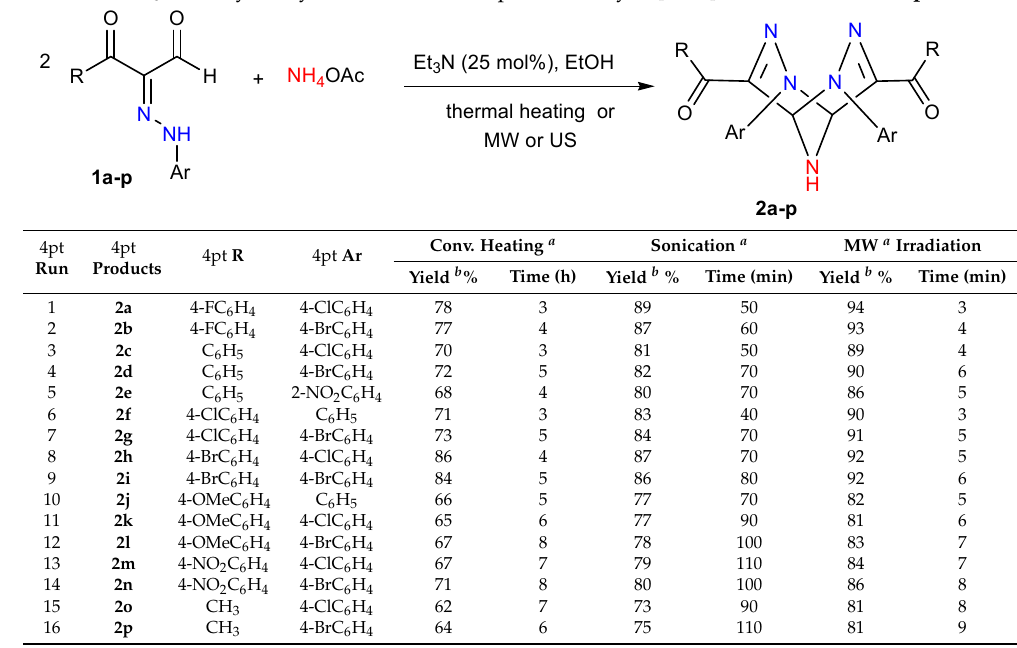
Table 2. Et 3 N-catalyzed synthesis of 2,3,6,7,9-pentaazabicyclo[3.3.1]nona-3,7-dienes 2a – p .